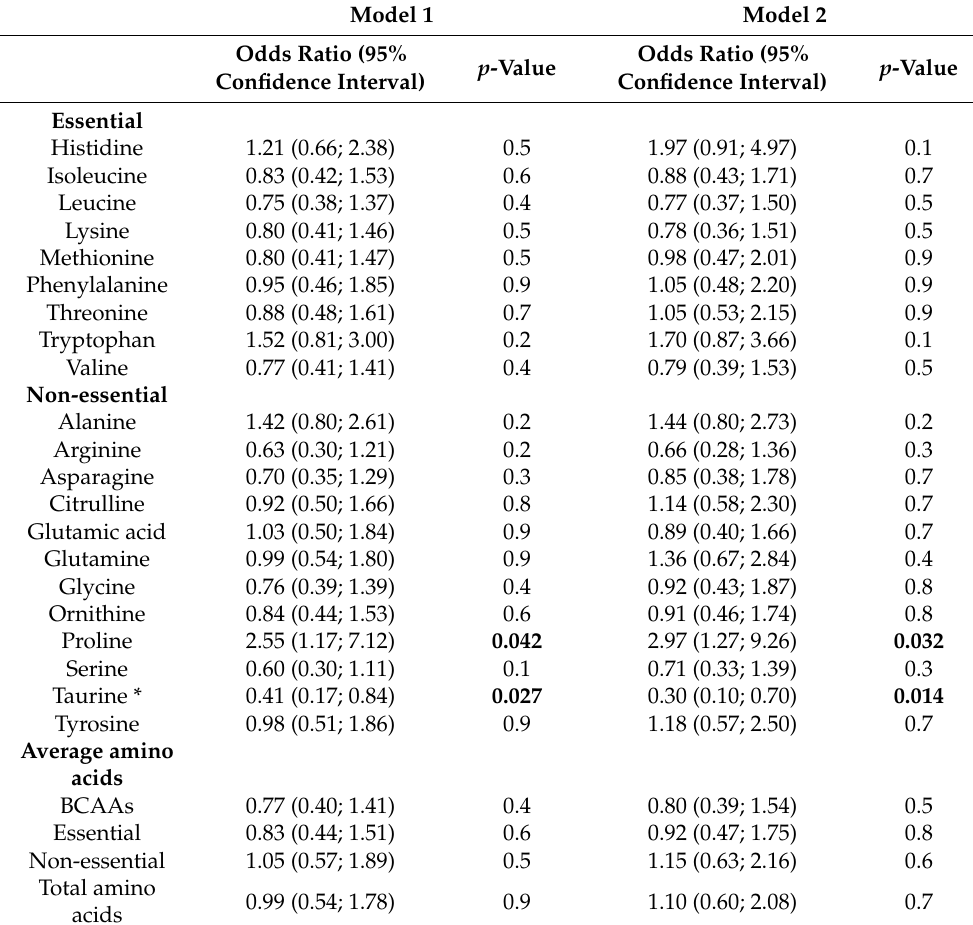
Table 5. Logistic regression analyses of plasma amino acid concentrations with the odds of severe